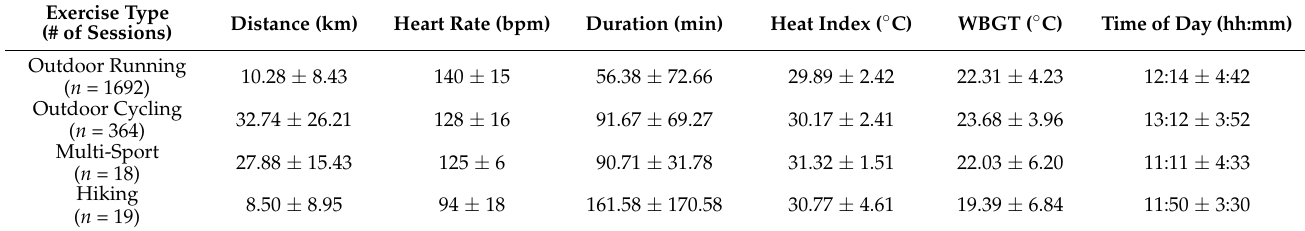
Table 1. Self-directed summer training (HAz) and environmental data. Data are describing averages for each training session. Data are reported as mean ± standard deviation (M ±